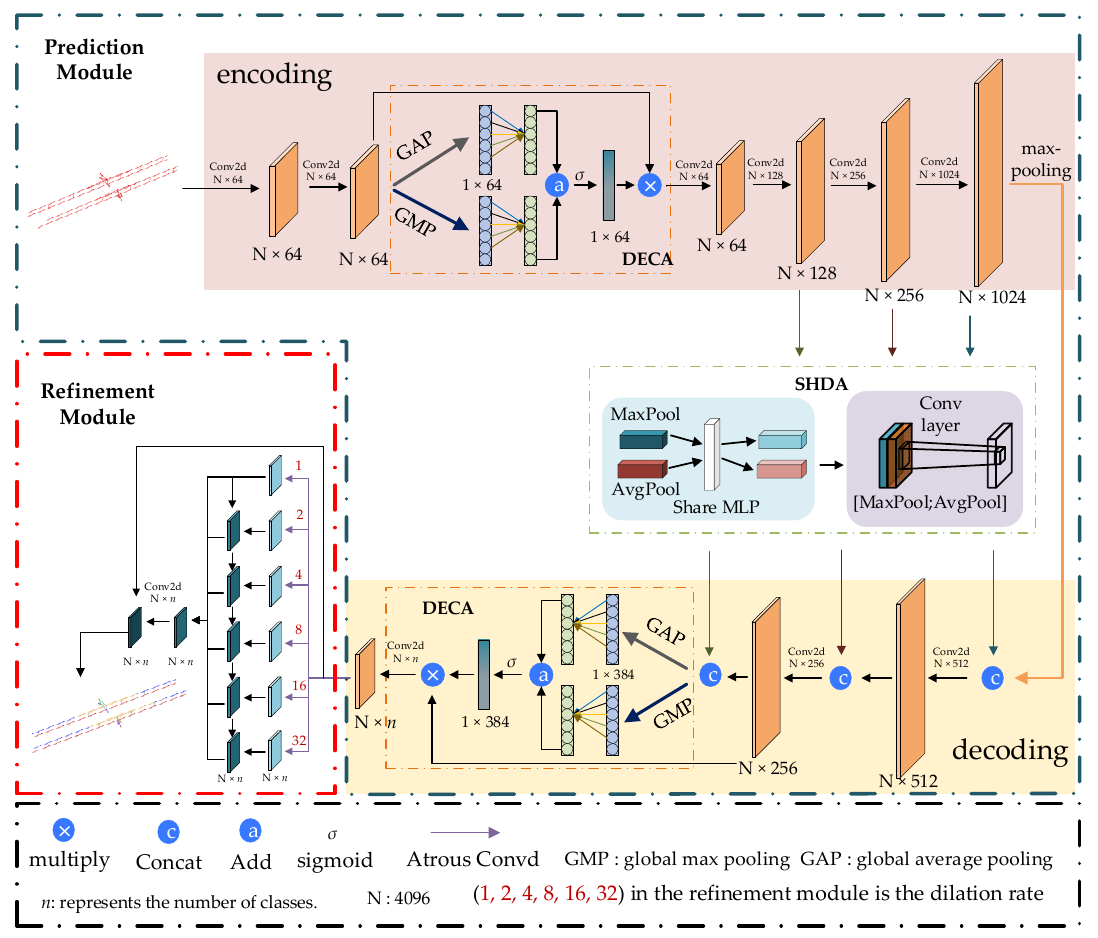
Figure 1. Overall framework diagram of the proposed PMFR-Net.